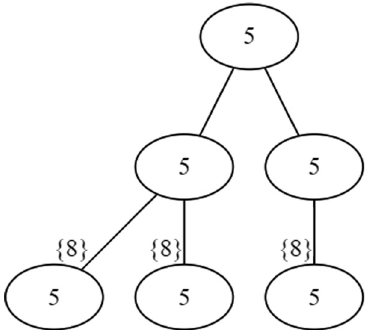
Figure 1: Tree directory for the Implementation of Step 2 ( ii ) , after assigning the fi rst three jobs of size 8.